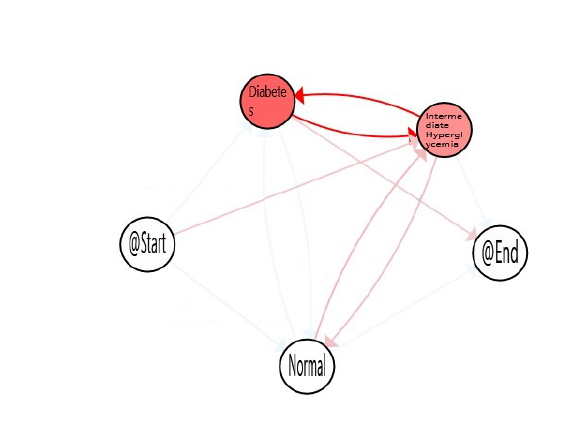
Figure 9. Difference enhancement model: All-Elderly.